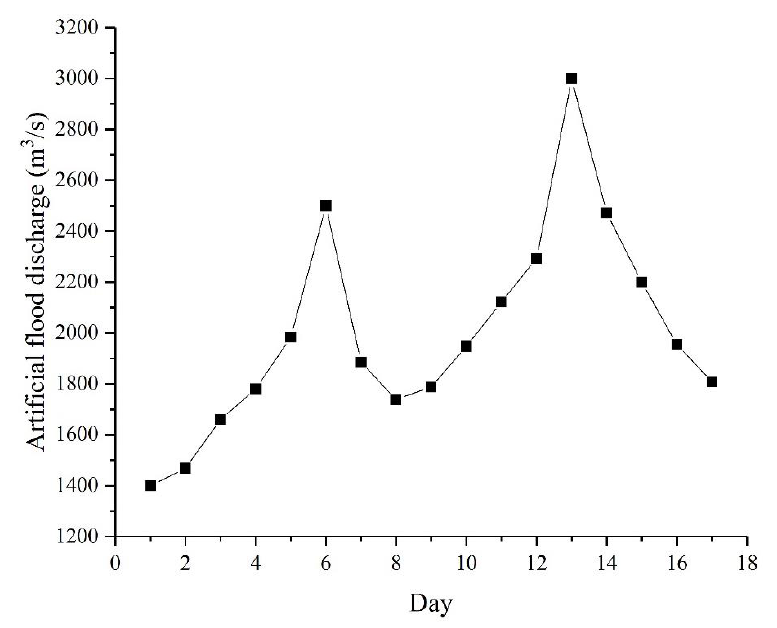
Figure 6. Artificial flood process line representing the year 1987. The flow constraint of the control section of the Liujiaxia reservoir during the transit flood season is shown in Table